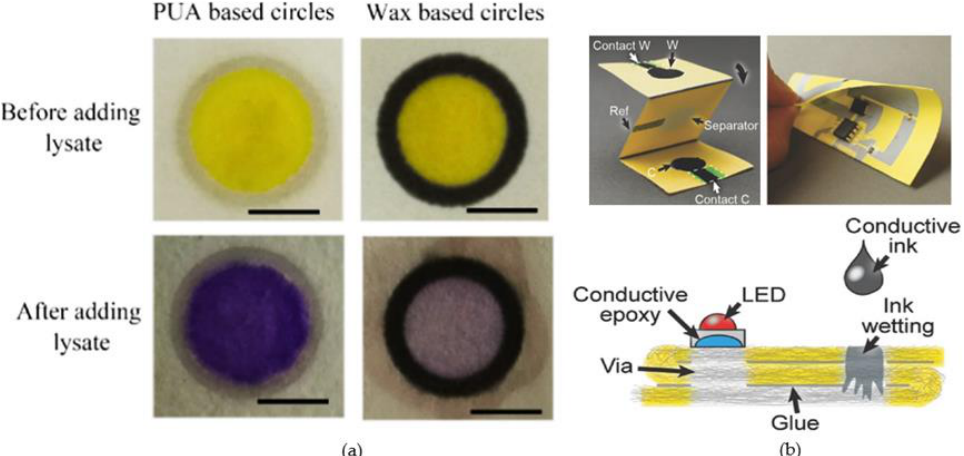
Figure 3. ( a ) Microfluidic paper-based analytical devices for colorimetric assays for E. coli BL21; ( b ) Photos and schematic diagram of the paper-based printed 3D circuit integrating electronics and microfluidics. ( a ) Reproduced with permission. [101] Copyright 2020, Sensors and Actuators B: Chemical. ( b ) Re-produced with permission. [37] Copyright 2016, Adv Mater.